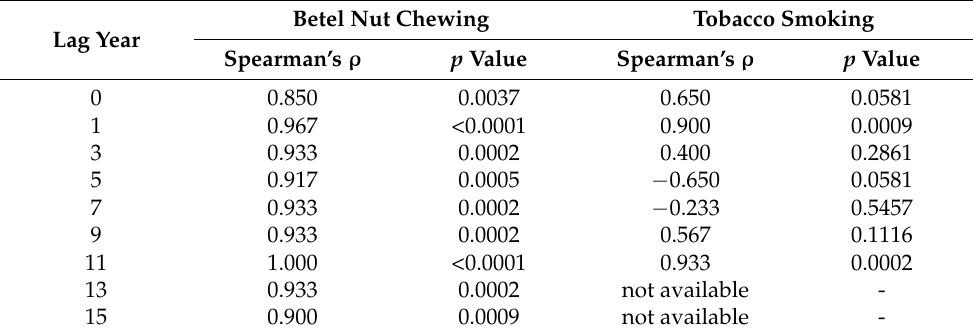
Table 1. Spearman rank correlation coefficients between oral cancer mortality among men in Taiwan from 1991 to 1999 and prevalence of exposures (tobacco smoking and betel-nut chewing) at various lag years. Betel Nut Chewing Tobacco Smoking Lag Year Spearman’s ρ p Value Spearman’s ρ p Value 0 0.850 0.0037 0.650 0.967 <0.0001 0.933 0.933 0.933 0.0002 0.567